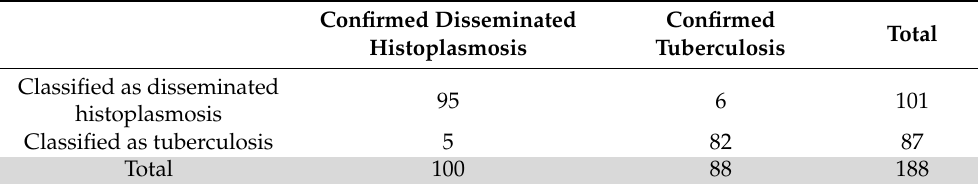
Table 2. Performance of the multivariate model to classify patients as disseminated histoplasmosis or tuberculosis.